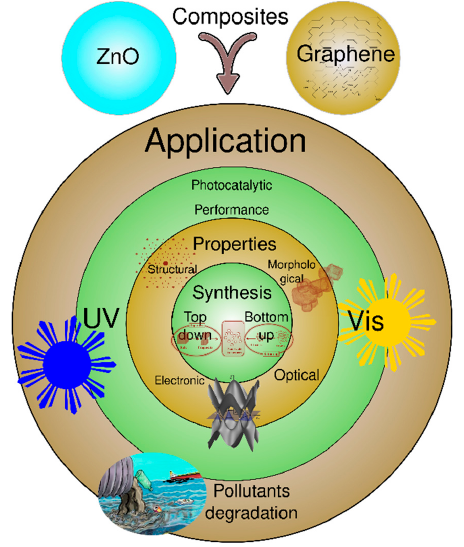
Figure 9. A conceptual scheme for the study of ZnO–graphene composites.